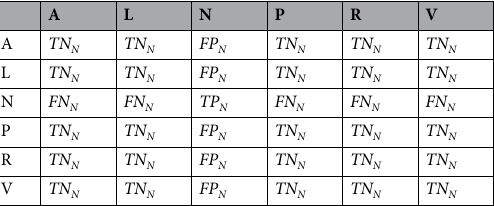
Table 4. Instructions for the definitions of TP , TN , FP , and FN for N